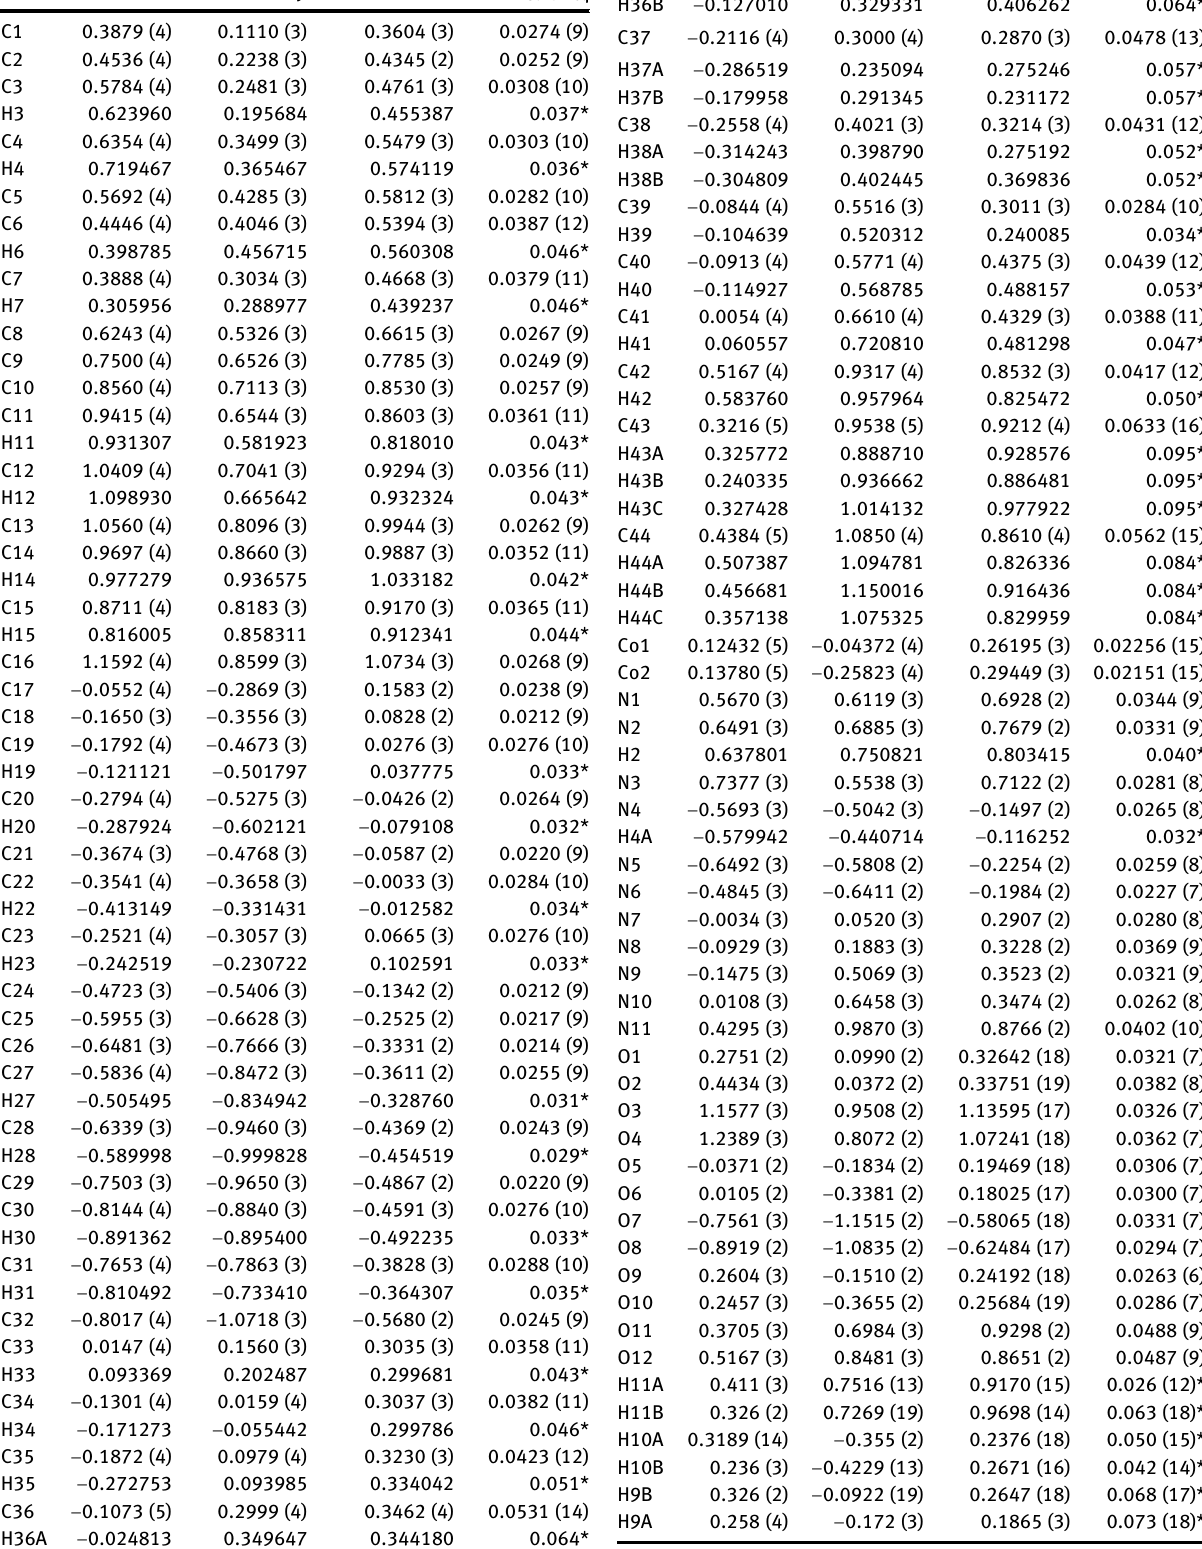
Table  : Fractional atomic coordinates and isotropic or equivalent isotropic displacement parameters (Å 